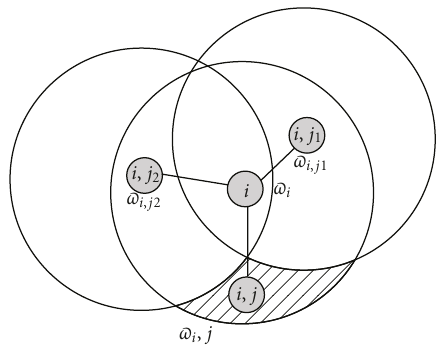
Figure 2: Possible location of neighboring node (cid:2) i , j .